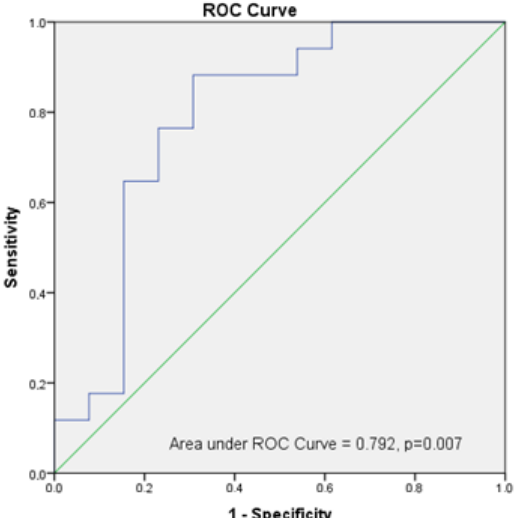
Figure 6. Analysis of ROC Curve of RF-CSA/weight to predict sarcopenia in post-critical COVID-19 outpatients.